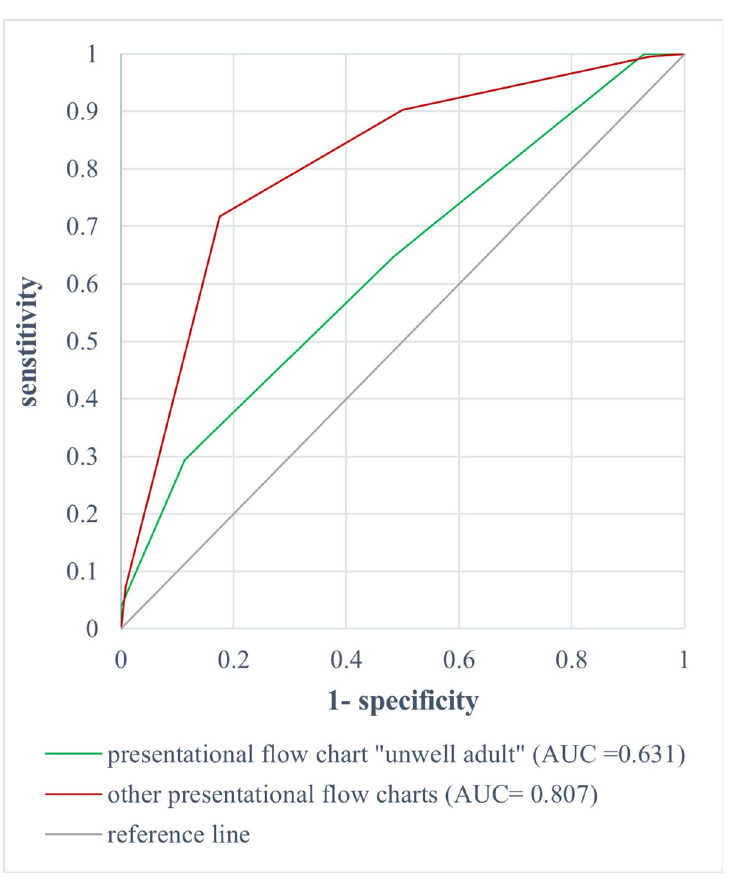
Fig 6. ROC analysis of MTS level and admission to ICU for patients aged � 65 years for the presentational flow chart “unwell adult” (AUC = 0.631 [0.547–0.715] vs. the other flow charts (AUC = 0.807 [0.790–0.824]).